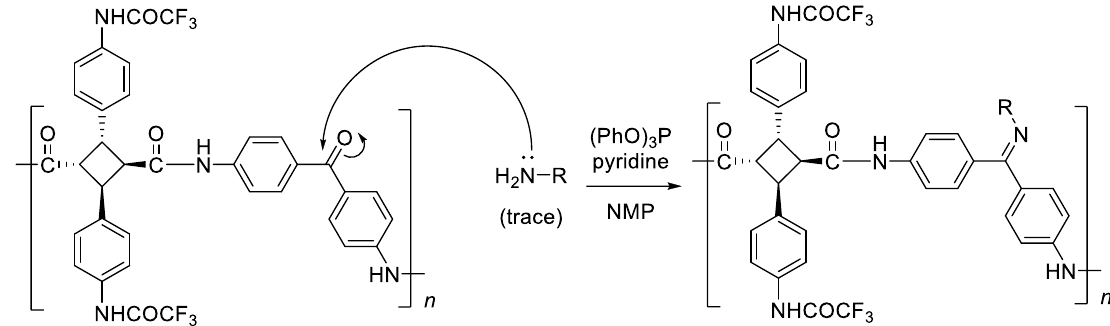
Figure S2: 13 C NMR spectrum of 4-(trifluoroacetamido)cinnamic acid (100 MHz; solvent, DMSO- d 6 ). Figure S3: 1 H NMR spectrum of 4,4 (cid:48) -bis(trifluoroacetamido)- α -truxillic acid (ATA-F1) (400 MHz; solvent, DMSO- d Figure S4: 13 C NMR spectrum of ATA-F1 (100 MHz; solvent, DMSO- d 6 ). Figure S5: 1 H NMR spectrum of 4,4 (cid:48) -bis(pentafluoropropionamido)- α -truxillic acid (ATA-F2) (400 MHz; solvent, DMSO- d 6 ). Figure S6: 13 C NMR spectrum of ATA-F2 (100 MHz; solvent, DMSO- d 6 ). Figure S7: ESI-FT-ICR mass spectrum of the ATA-F1. Figure S8: ESI-FT-ICR mass spectrum of the